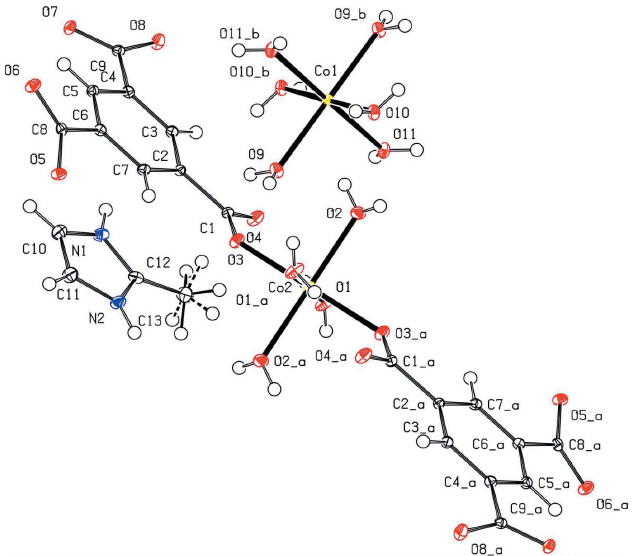
Figure 1 The molecular structure of 1 with displacement ellipsoids drawn at the 50% probability level. Symmetry codes: (_a) 2 (cid:2) x , (cid:2) y , 2 (cid:2) z ; (_b) 2 (cid:2) x , 1 (cid:2) y , 1 (cid:2) z